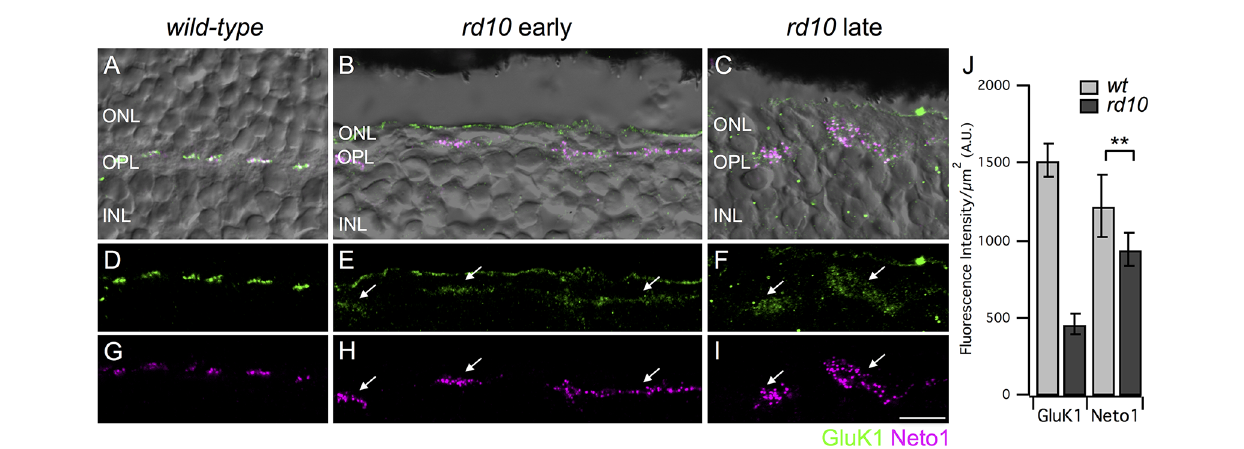
FIGURE 2 | Persistence of kainate receptors after photoreceptor degeneration. (A–C) Micrographs showing the localization of GluK1 (green) and Neto1 (magenta) overlayed on transmitted light images (gray) of wild-type and rd10 retina. Clusters of GluK1 and Neto1 were localized to the OPL. Note that some green fluorescence was also evident at the outer edge of the ONL but this staining was not included in the analysis as it was not associated with bipolar cell dendrites. (D–F) Same regions as in (A–C) showing GluK1 immunoreactivity (arrows) in wild-type and rd10 retina. Note that for illustration purposes, confocal gain and laser power were increased to show residual GluK1 staining in the rd10 retina. (G–I) Same regions as in (A–C) showing clusters of Neto1 immunoreactivity (arrows). Confocal acquisition settings were identical for panels (G–I) . (J) Quantification of fluorescence intensity for regions-of-interest (ROI) from retinae from the late time point. Each ROI was a polygonal shape surrounding a separate cluster of GluK1/Neto1 puncta. There was a significant reduction in GluK1 immunoreactivity in rd10 retina compared to wild-type (unpaired t -test, ∗∗ P = 0.001). Neto1 intensity was comparable between genotypes (unpaired t -test, ∗∗ P = 0.290). Data were obtained from 57 clusters from 3 rd10 retinae and 176 clusters from 3 wild-type retinae). Scale bar = 10 μ m.